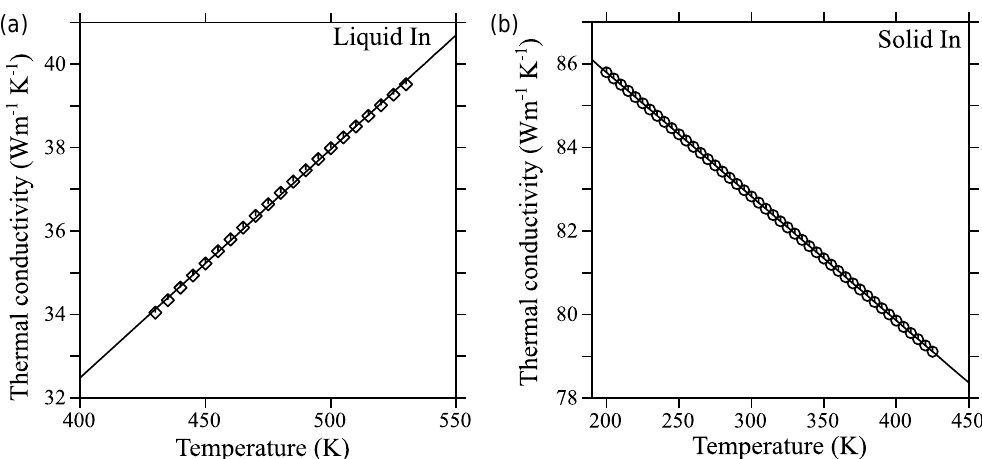
Figure 6. Comparison between calculated (solid line) and experimental (symbols) thermal conductivities of pure In in ( a ) liquid and ( b ) solid state.